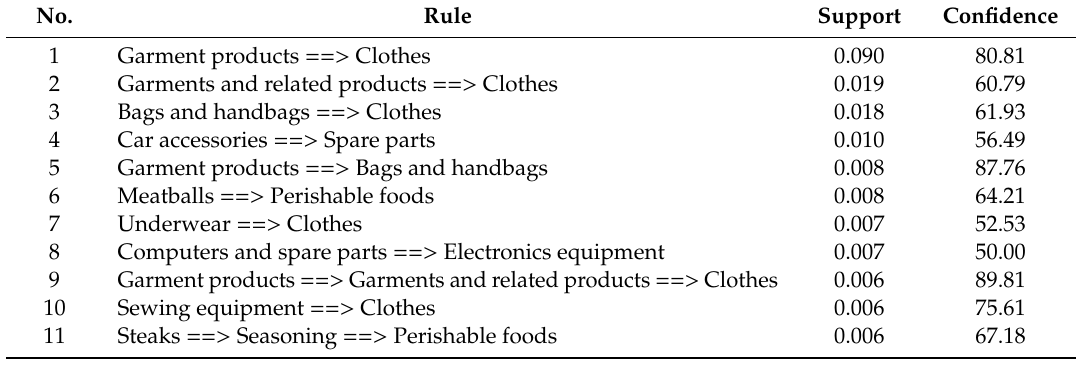
Table 3. Product association rules.